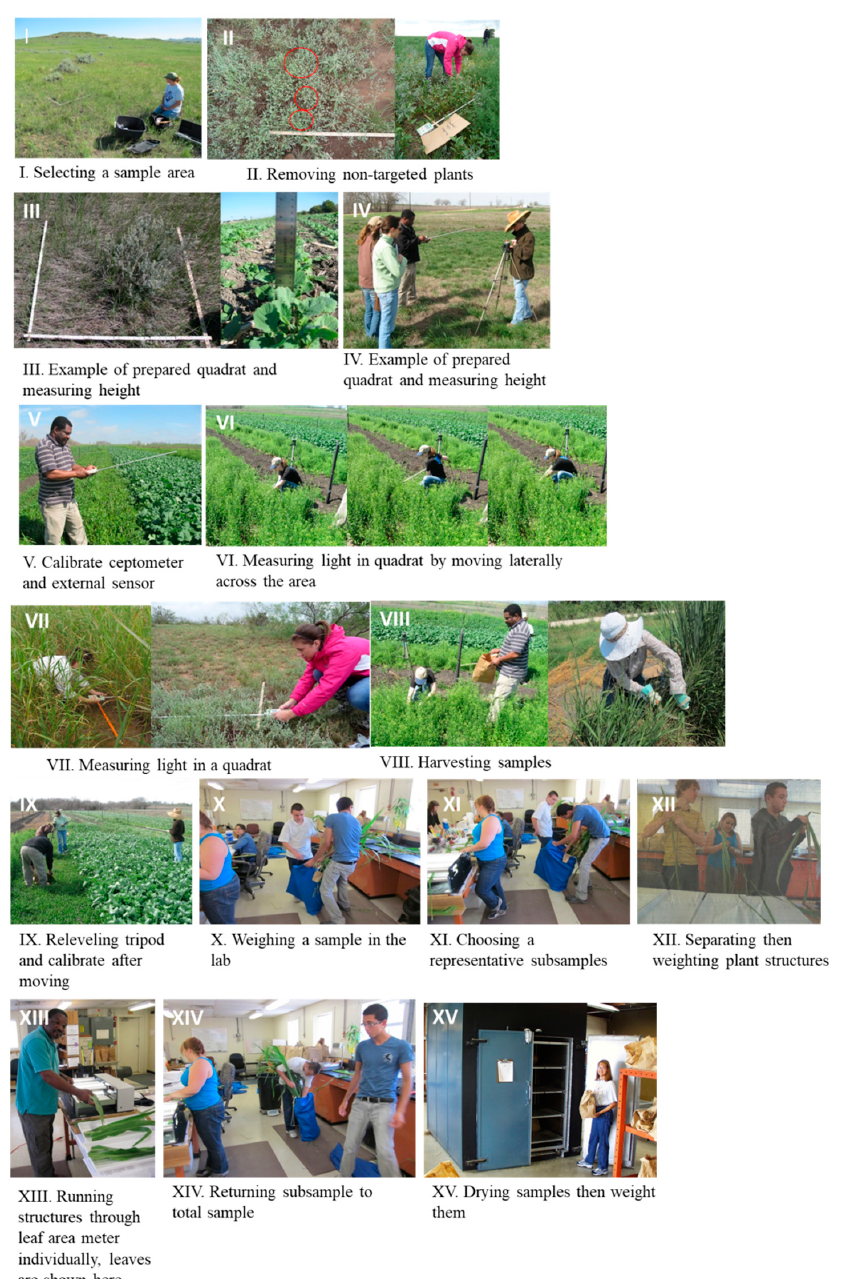
Figure 1. A generalized protocol for sampling plants to determine radiation use efficiency (RUE) from field measurements. The field protocol pictures are adapted from the Grassland Soil and Water Research Laboratory website available at https://www.ars.usda.gov/plains-area/temple-tx/grassland-soil-and-water-